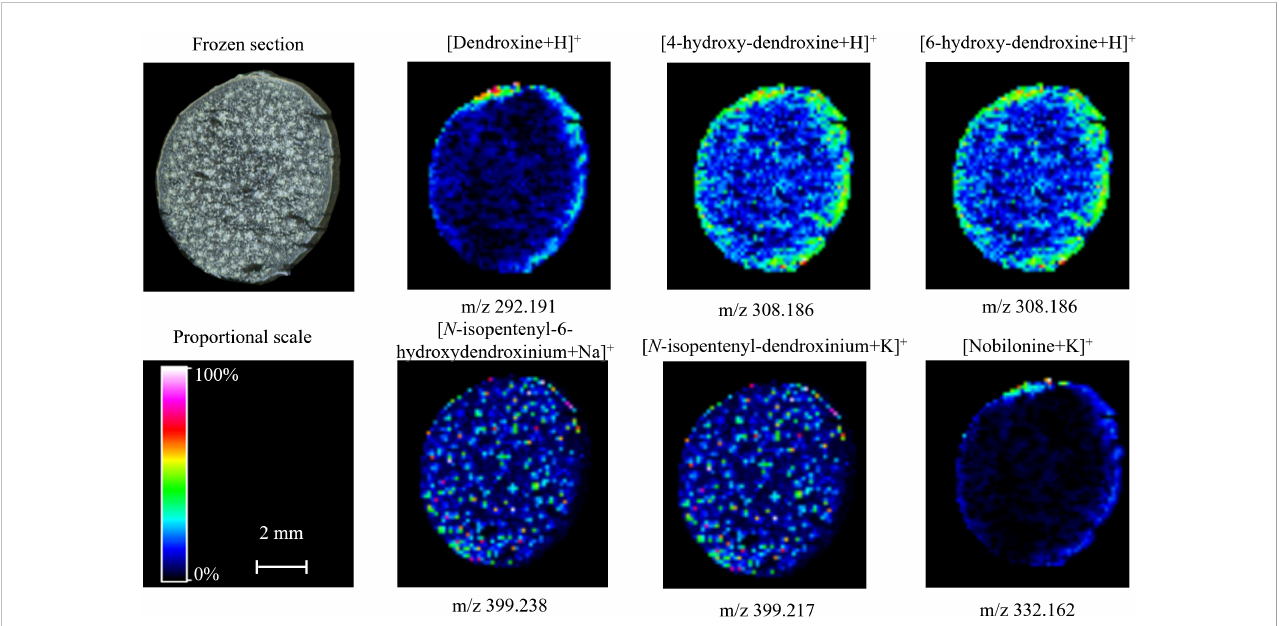
FIGURE 5 Distribution of dendroxine-type alkaloids in mature Dendrobium nobile stem imaged by MALDI-MSI. Heat maps were applied to present the relative distributions and contents.